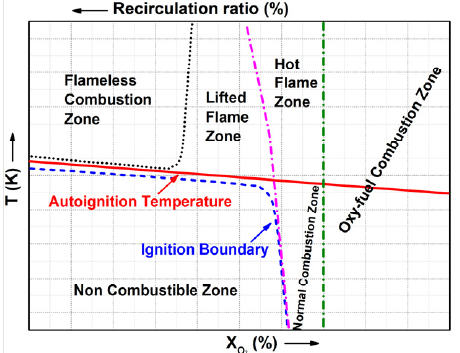
Figure 1. Schematic of different combustion regimes.